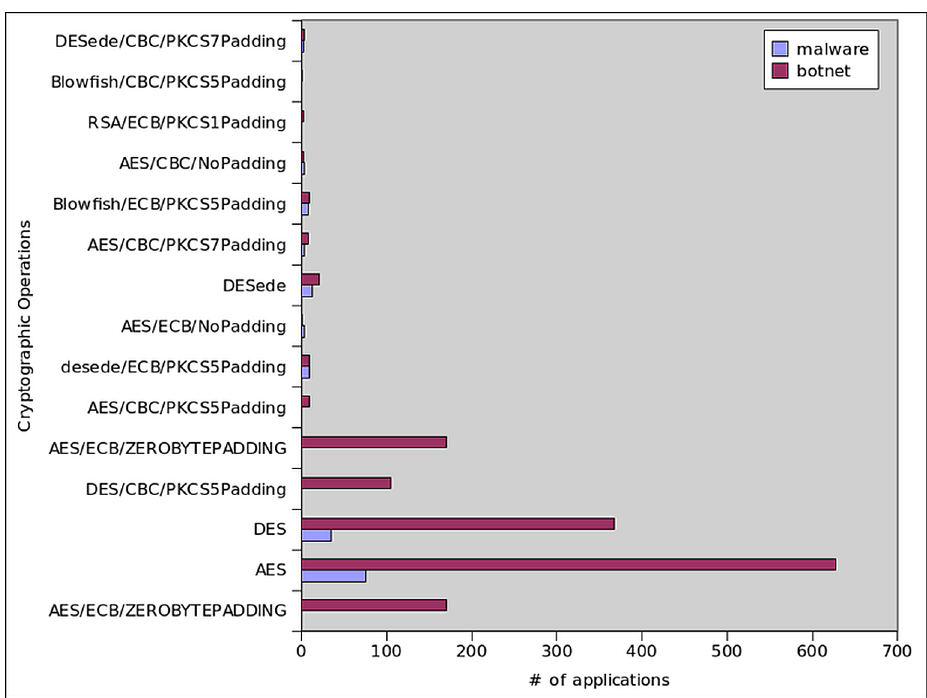
Fig 10. Cryptographic Operations.